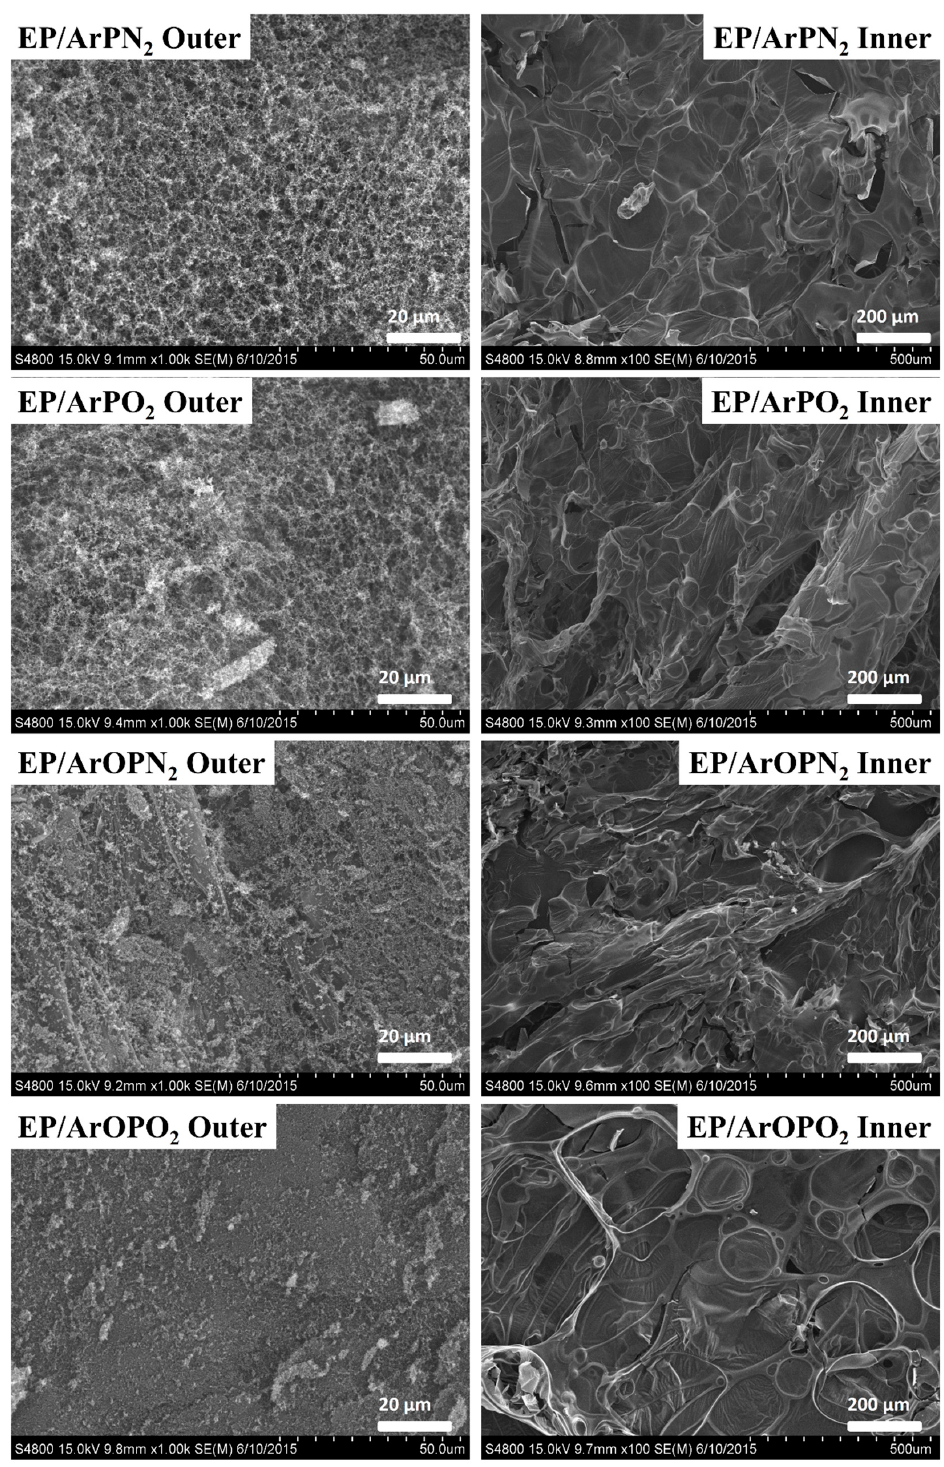
Figure 6. SEM images of surface for residual char of pure EP and EP/polysulfone composites.